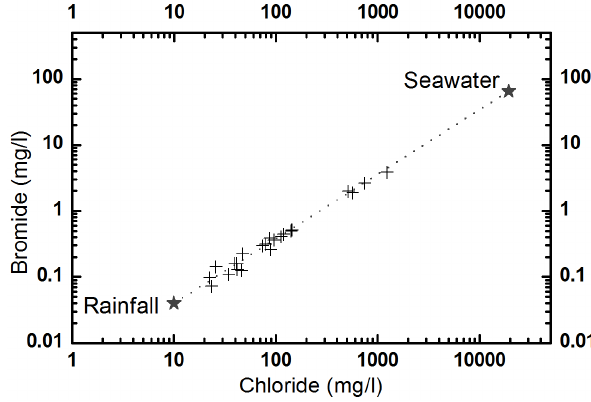
Figure 4. Br versus Cl concentrations of groundwater at the 12 sites